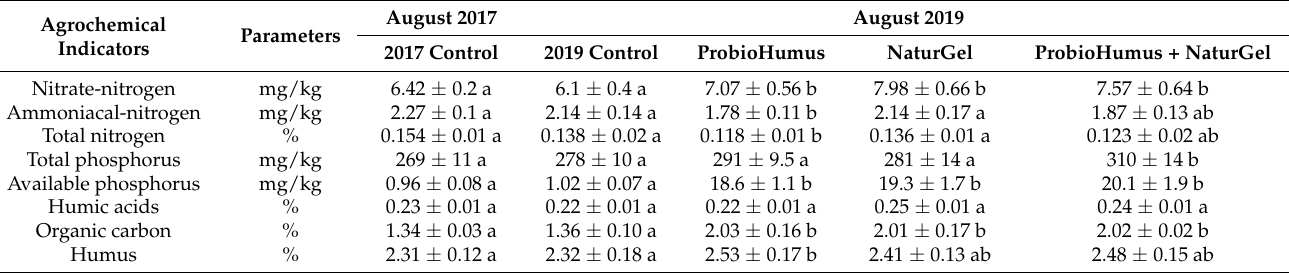
Table 7. Effect of probiotic preparations on soil agrochemical